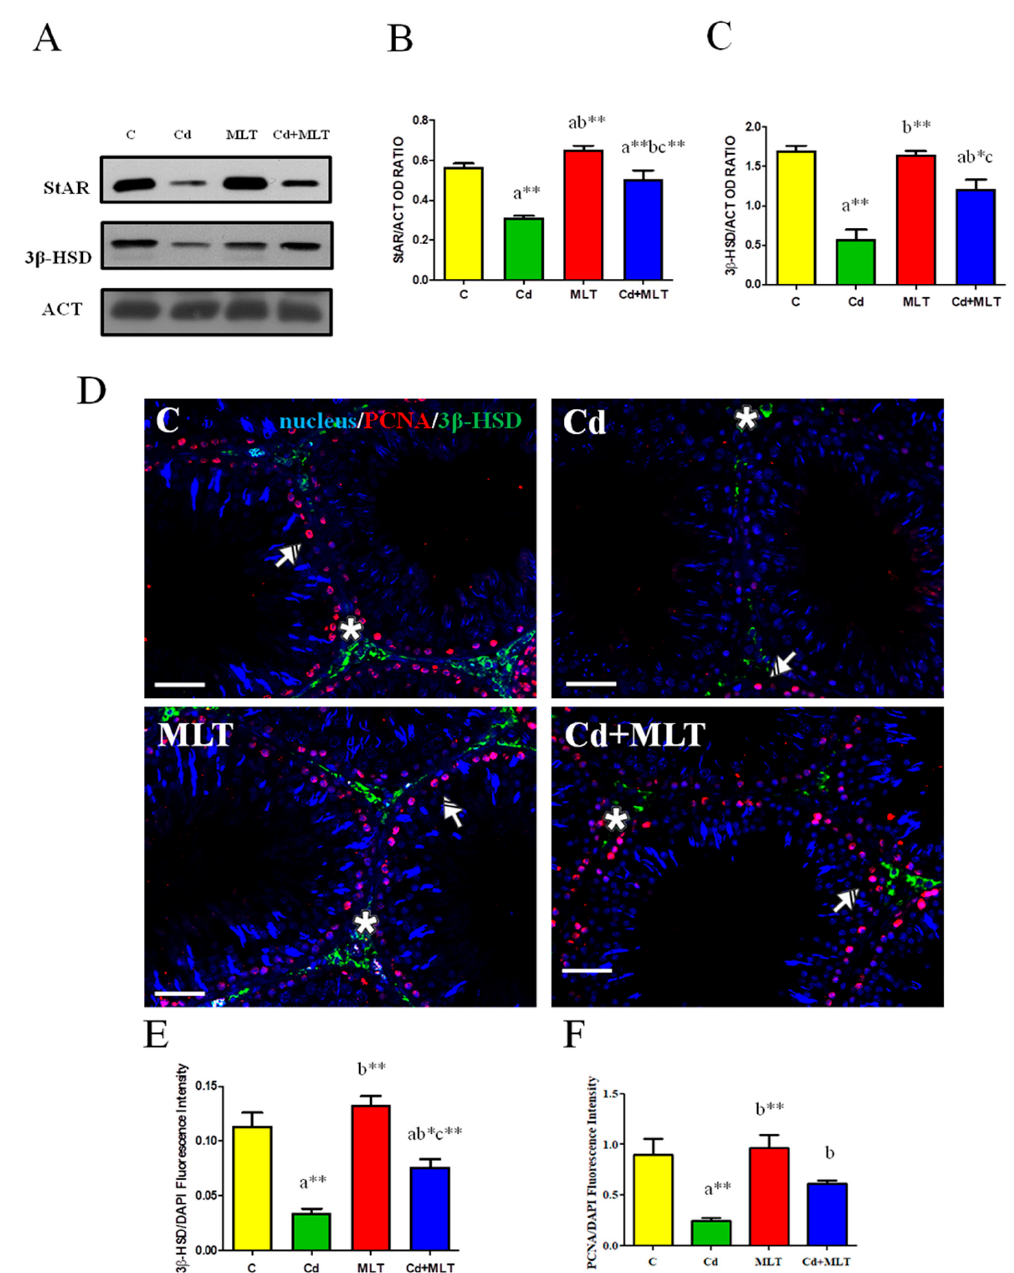
Figure 3. Steroidogenesis analysis of C-, Cd-, and/or MLT-treated rat testis. ( A ) WB analysis showing the expression of StAR (31 kDa), 3 β -HSD (42 kDa), and β -actin (44 kDa) in testes of animals treated with Cd and/or MLT. ( B , C ) Histograms showing the relative protein levels of StAR and 3 β -HSD, respectively. Data were normalized with β -actin and reported as OD ratio. ( D ) IF analysis of 3 β -HSD (green) and PCNA (red) in testes of animals treated with Cd and/or MLT. Slides were counterstained with DAPI-fluorescent nuclear staining (blue). Scale bars represent 20 µ m. Striped Arrows: SPG; Asterisk: LC. ( E , F ) Histogram showing the quantification of 3 β -HSD and PCNA fluorescence signal intensity, respectively, using ImageJ. All the values are expressed as means ± SEM from 6 animals in each group. a: significant difference versus C group, p < 0.05; b: significant difference versus Cd group, p < 0.05; c: significant difference versus MLT group, p < 0.05; *: p < 0.01; **: p < 0.001.